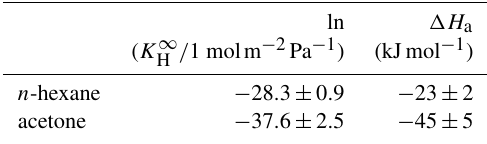
Table 2. Adsorption isotherm of n -hexane and acetone on